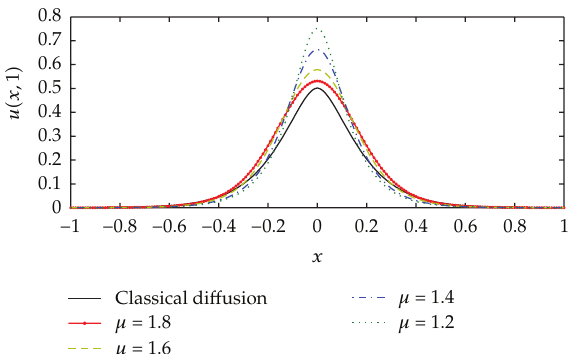
Figure 3: Numerical solutions for (cid:3) 5.5 (cid:5) with (cid:3) 5.8 (cid:5)